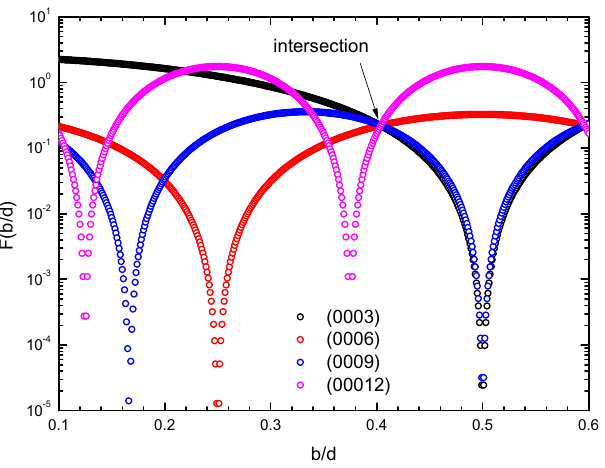
Figure 6. F(b/d) versus b/d plots for Bi (0 0 0 s) planes. The curves intersect at one point when b/d is